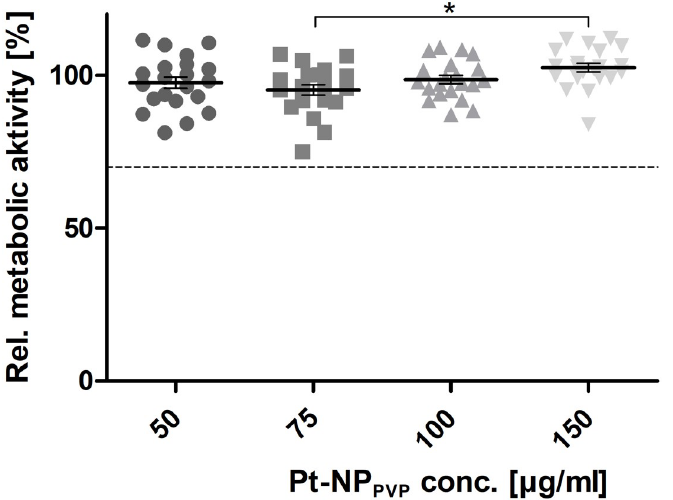
Fig 4. Determination of the metabolic activity of the HEI-OC1 cells following exposure to Pt-NP PVP . Metabolic activity of the HEI-OC1 cells grown in culture medium containing 50 μ g/ml -150 μ g/ml Pt-NP PVP was determined by indirect dehydrogenases driven reduction of resazurin to the highly fluorescent resorufin. Fluorescence units (FU) were measured in 48 h cultivation assays (N = 6 independent experiments, n = 18). The resulting fluorescence intensities were also related to those obtained from the reference and calculated as percentage [%]. Each data point is presented as mean and SEM. One-way ANOVA with Tukey’s multiple comparison test was performed for statistical assessment ( * p � 0.05). The dashed line represents the cytotoxicity limit (70%).